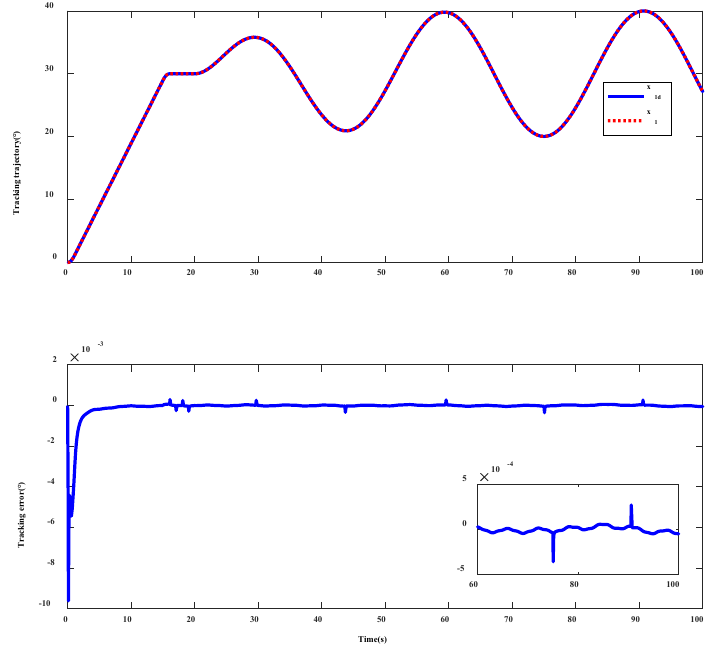
Figure 9. The tracking performance of the ADRAC.